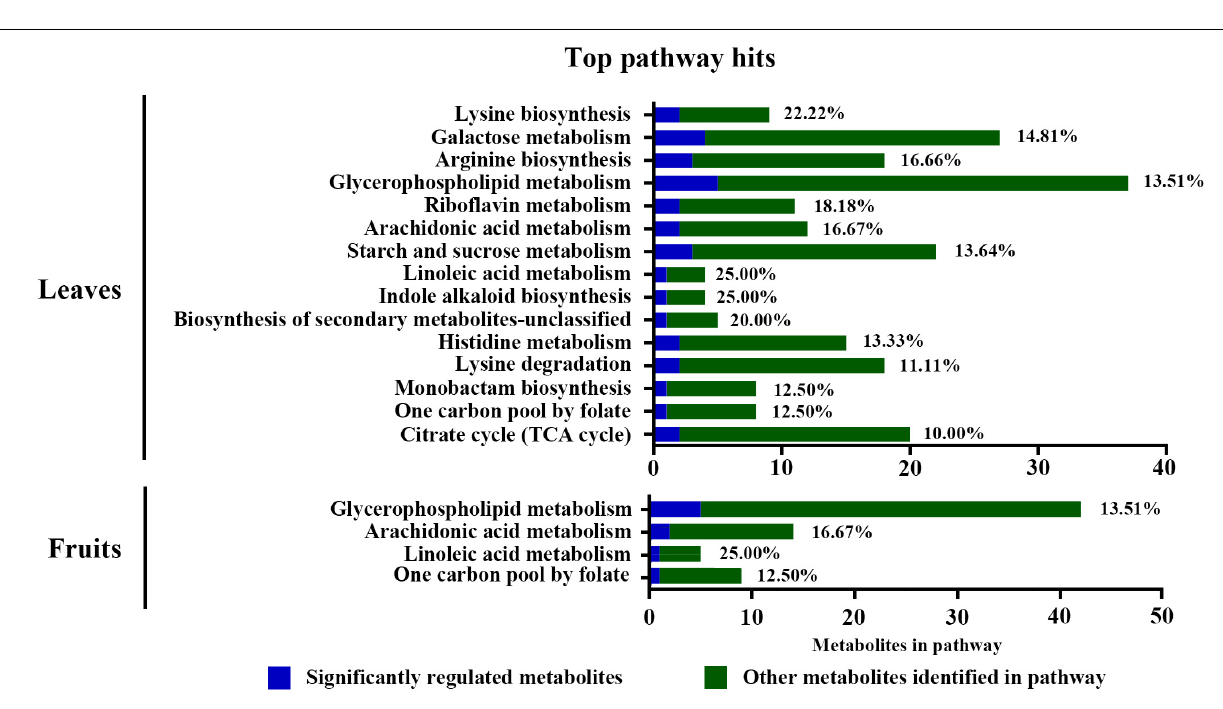
Frontiers in Plant Science |